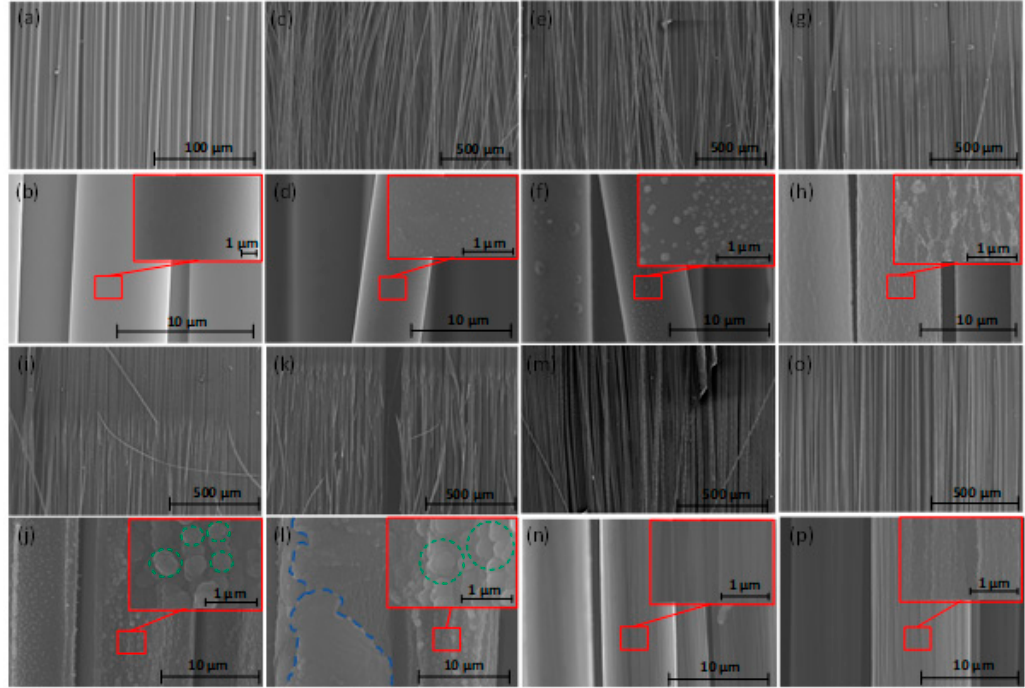
Figure 6. Scanning electron microscopy (SEM) micrographs of the irradiated samples. ( a , b ) bTCF, ( c , d ) TCF 3.75 W , ( e , f ) TCF 4.25 W , ( g , h ) TCF 4.75 W , ( i , j ) TCF 7.5 W , ( k , l ) TCF 10 W , ( m , n ) bPCF, and ( o , p